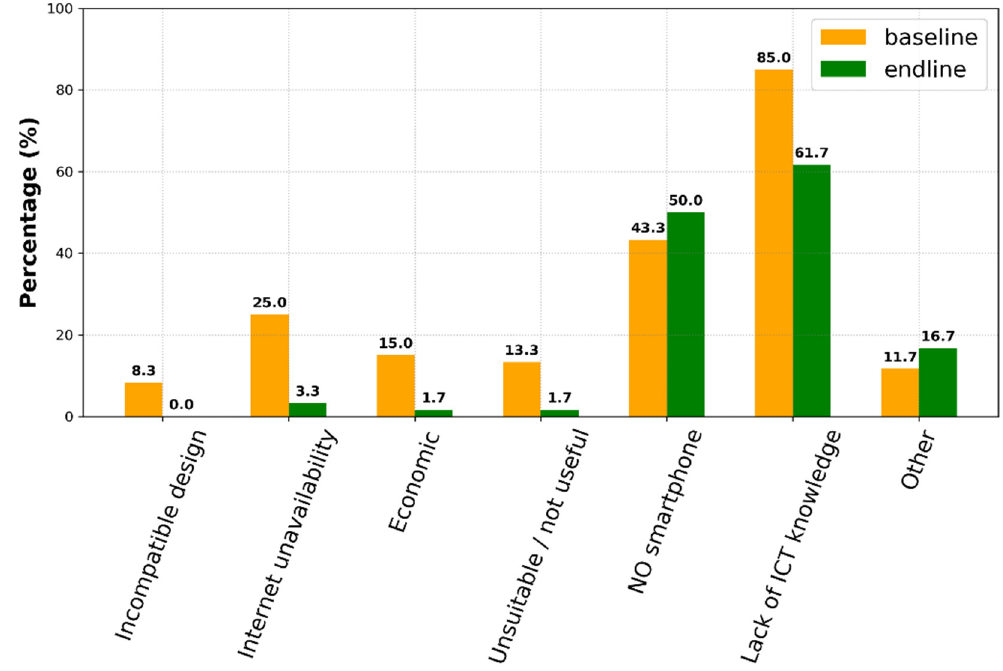
Figure 10. Limitations of uptake available hydroclimatic information by periurban farmers in the Lower Bengal Delta, Khulna, Bangladesh.